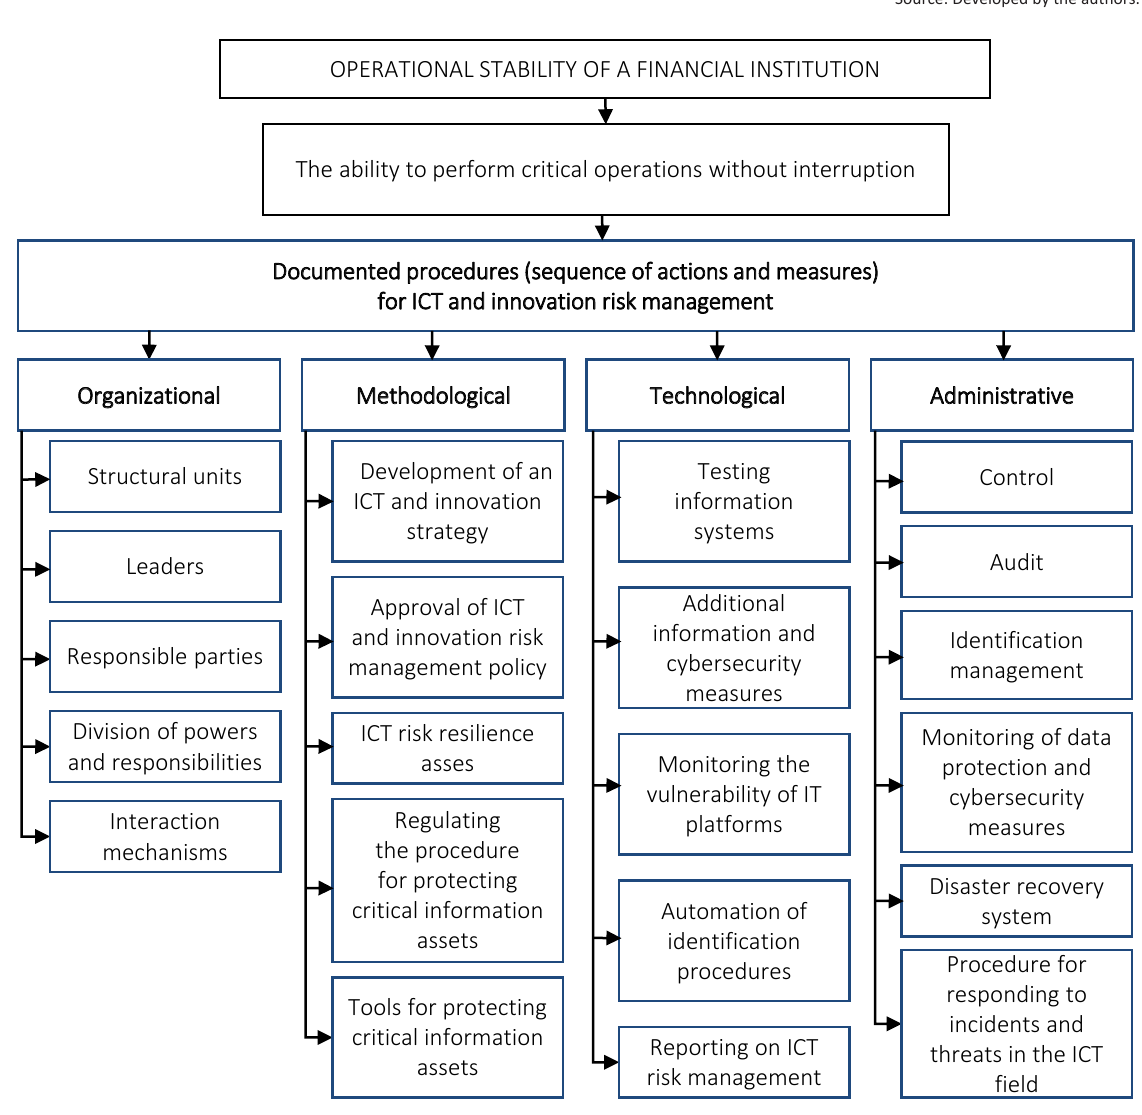
Figure 3. Orientation of innovation risk management procedures in financial